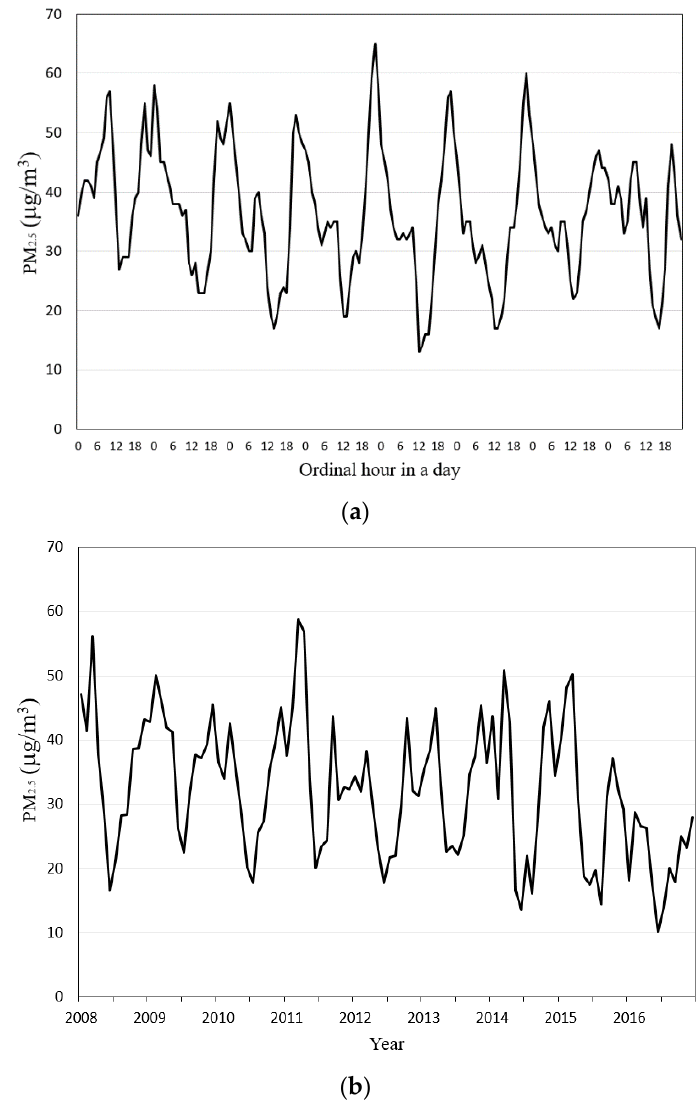
Figure 3. ( a ) The daily and ( b ) yearly periodic trends of PM 2.5 time series.